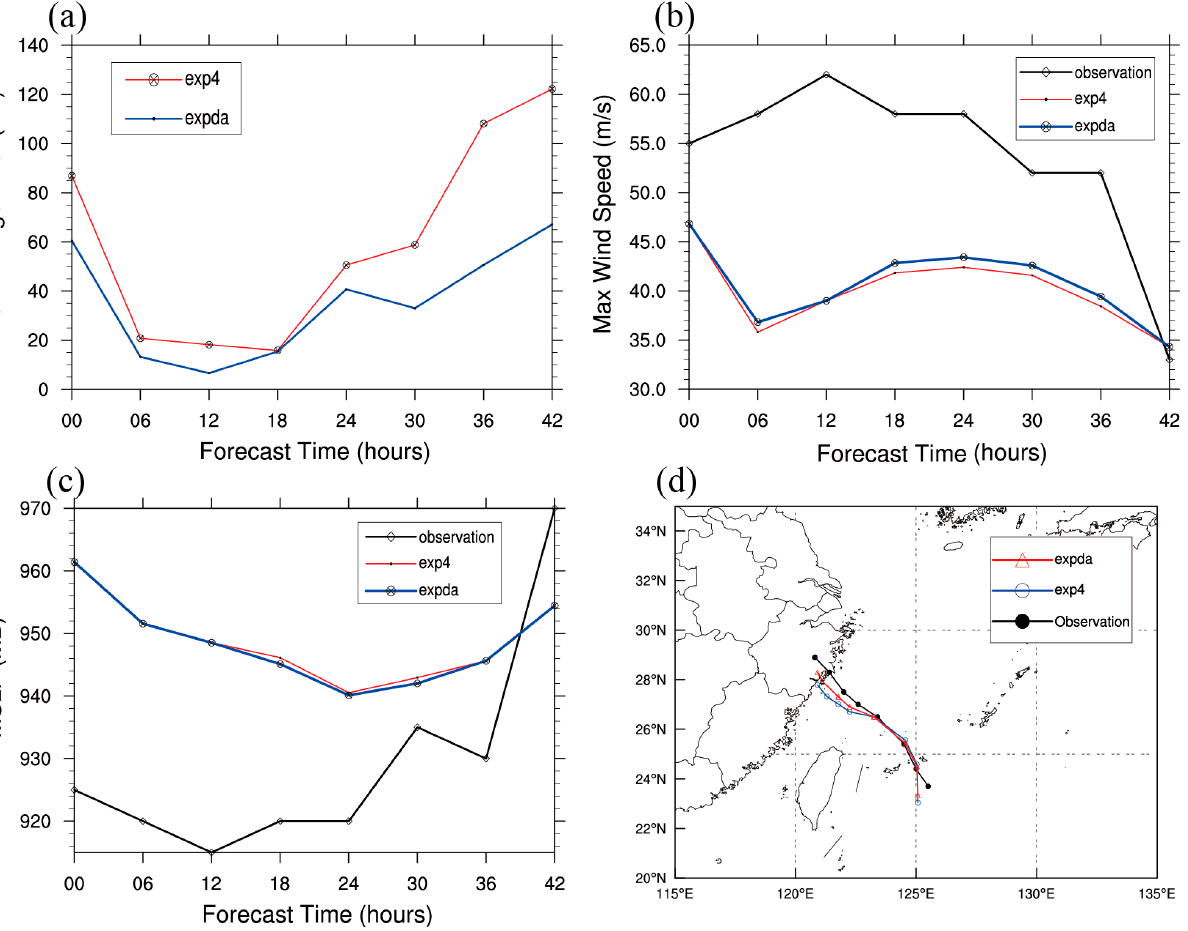
Figure 12. ( a ) mean range error (units: km), ( b ) max wind speed (units: m/s), ( c ) minimum sea level pressure (units: MB), and ( d ) the typhoon’s tracks for numerical experiments and observed track from 0600 UTC 8 August to 0000 UTC 10 August 2019.